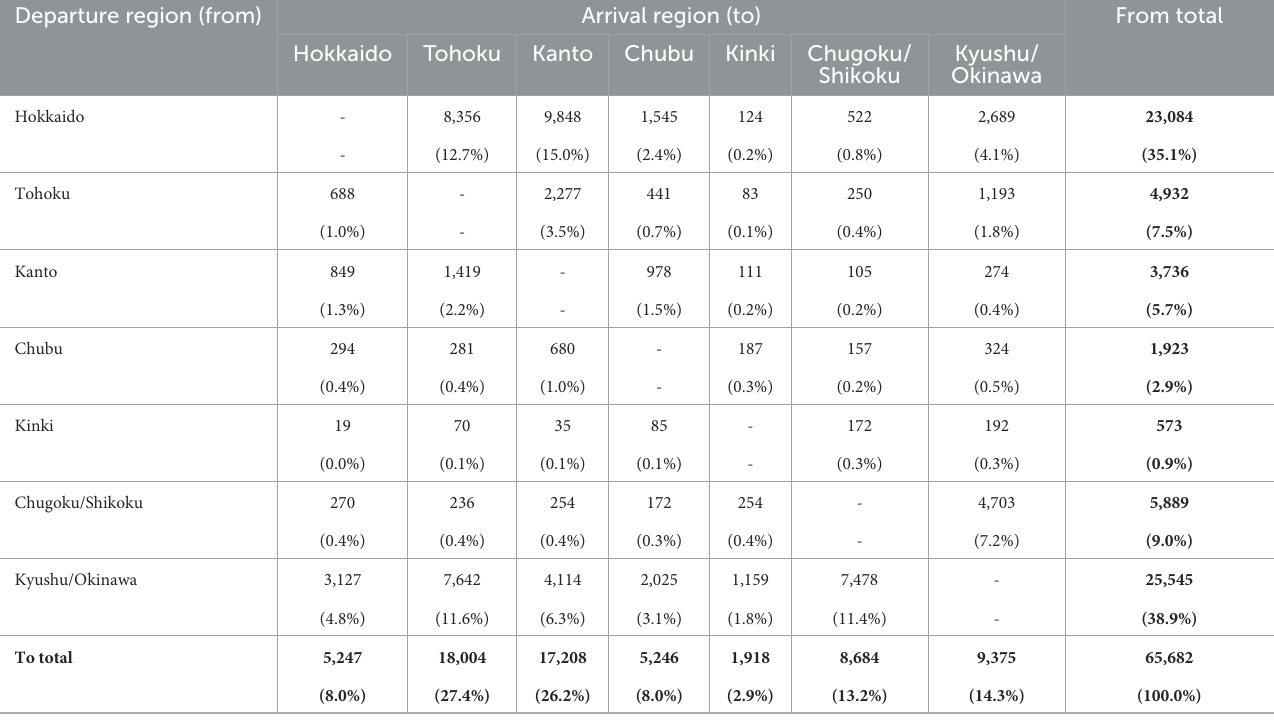
TABLE 2 The number of inter-regional movements of beef cows. Departure region (from)